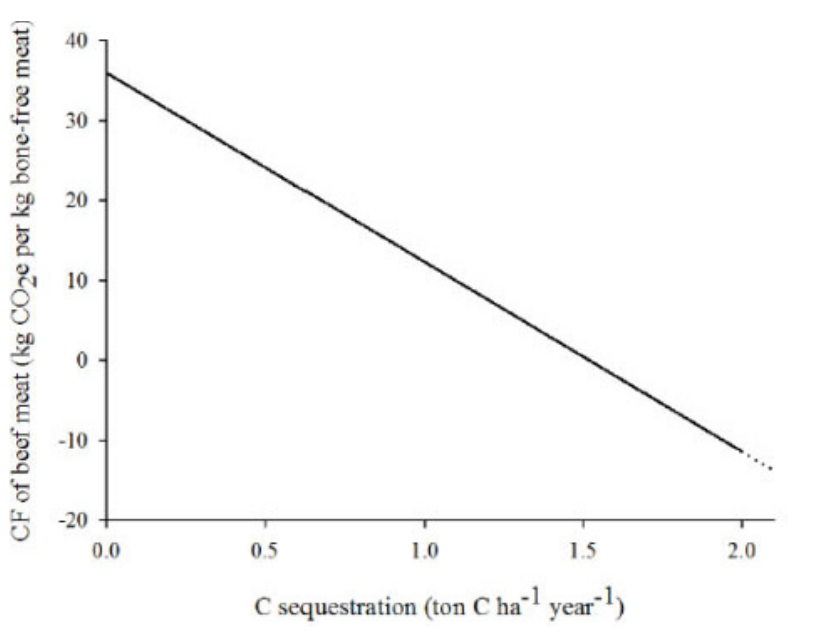
Figure 9: Relation between carbon footprint of beef and carbon sequestration. Source: Röös E. and Nylinder J.